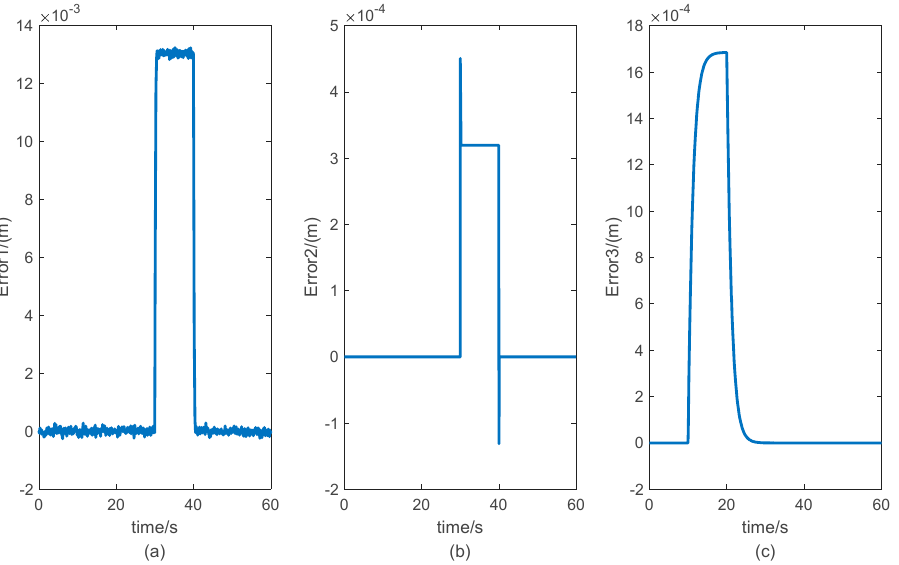
Figure 7. Curves of the error signals with faults (Agent 1). ( a ) Curve of the error signal of Fault 1. ( b ) Curve of the error signal of Fault 2. ( c ) Curve of the error signal of Fault 3.